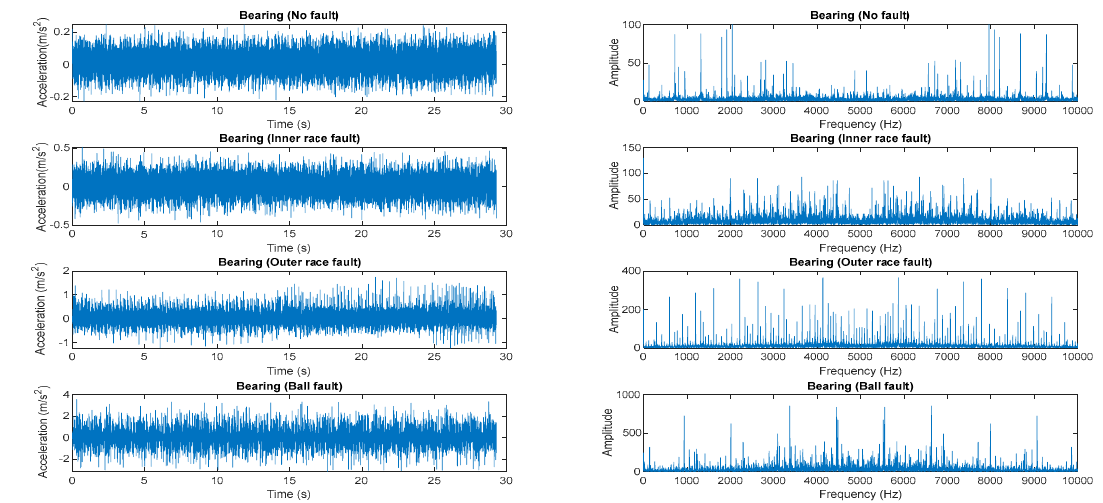
Figure 2. Acquired vibration signals and its corresponding FFT.